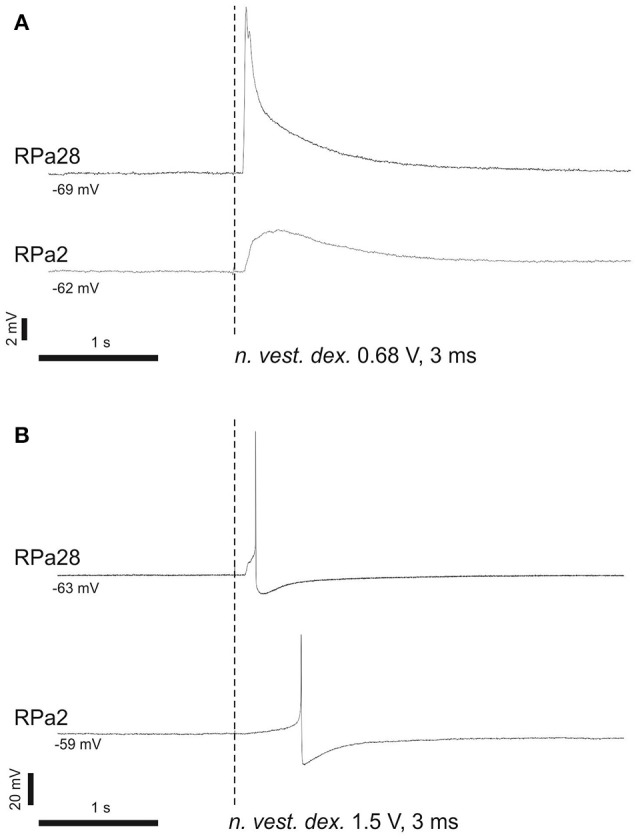
Command neurons of defensive behavior receive excitatory input from vestibular nerve. (A) Single shock 3 ms, 0.68 V; (B) single shock 3 ms, 1.5 V. Stimulation of n. vestibularis exerts EPSP (A) or an action potential (B) in ipsi- and contralateral command neurons for defensive behavior.